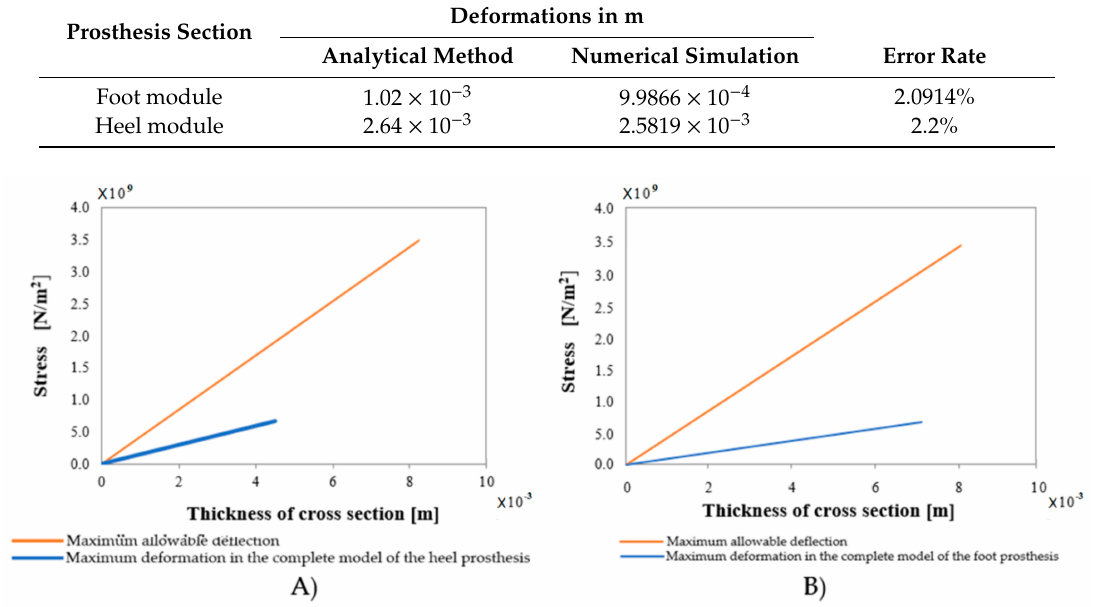
Figure 24. Analytically and numerically computed stresses and deformations for the complete prosthesis model. ( A ) Case 3.1. ( B ) Case